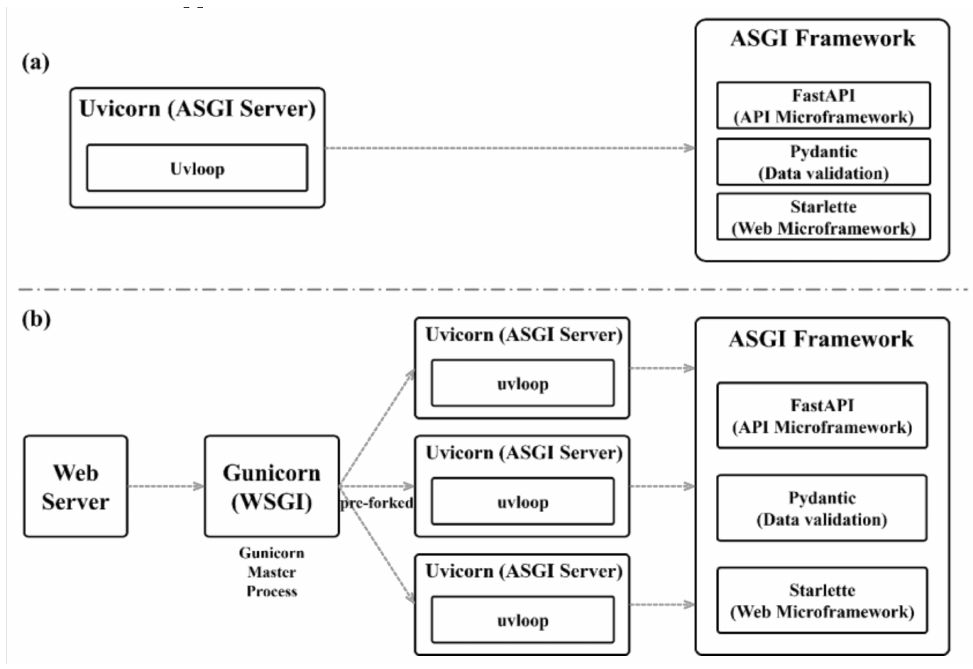
Figure 2. FastAPI-based single-process and multi-process models; ( a ) Single Process Model; ( b ) Multi-process